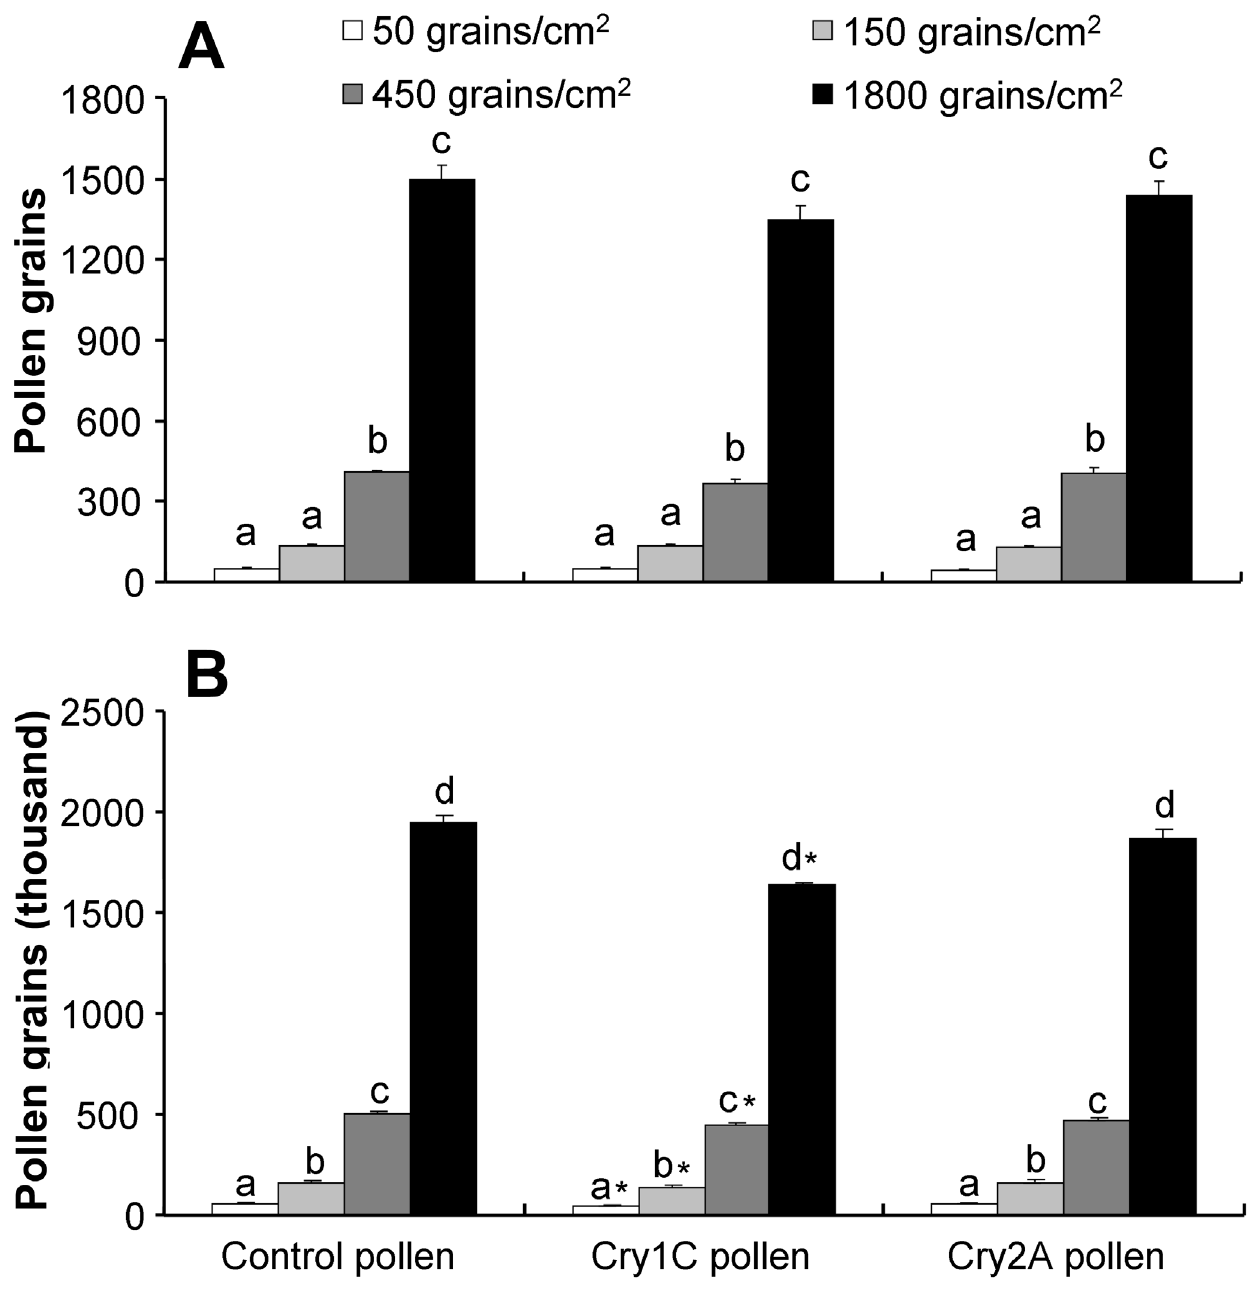
Figure 1. Rice pollen consumption per Bombyxmori larva. Lavae were fed mulberry leaves covered with different doses of pollen from Cry1C- or Cry2A-expressing Bt rice or pollen from the corresponding non-transformed varieties for (A) 3 d (short-term assay) and for (B) the entire larval stage (long-term assay). For each pollen type within each assay, bars with different letters are significantly different (one-way ANOVA with Tukey test), while asterisks indicate significant differences between the Bt pollen treatment and the corresponding non- Bt pollen treatment at the same pollen dose (Dunnett test). Values are means + SE, n=3.